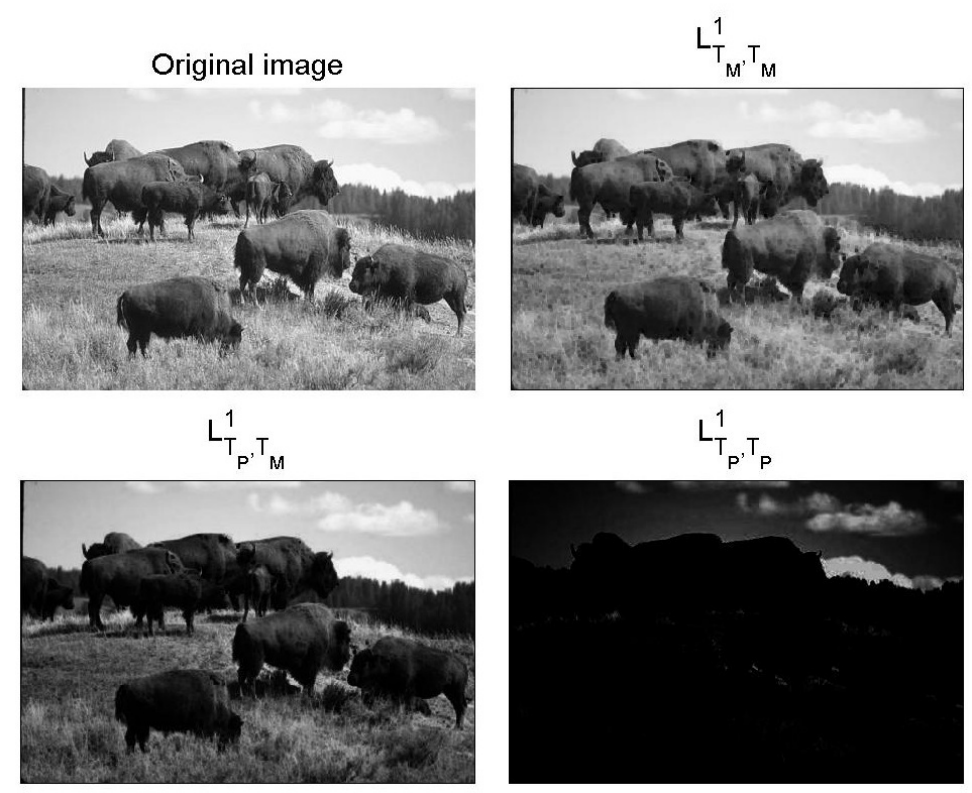
Figure 2: Comparative of lower constructors depending on different t-norms. T P is the product t-norm and T M the